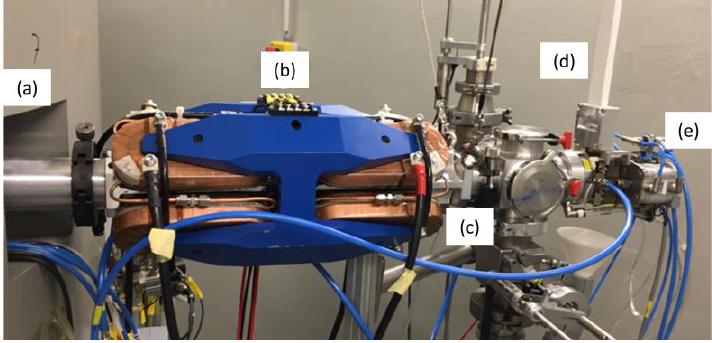
Fig. 3. The Automatic Focalization System installed in the cyclotron bunker: (a) cyclotron out-port; (b) Mini-PET beam line; (c) UniBEaM detector; (d) target receiving station of the Hyperloop; (e) Solid Target